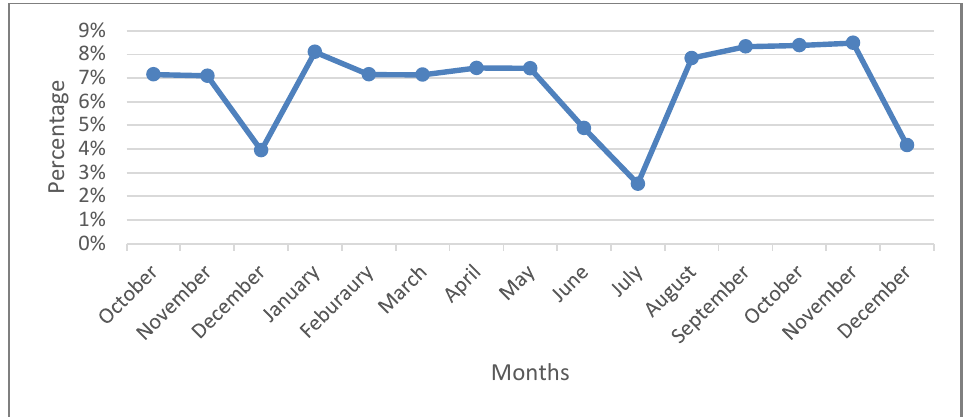
Figure 3: Monthly sale proportions of Movingo from October 2017 to December 2018. Source: MÄLAB,